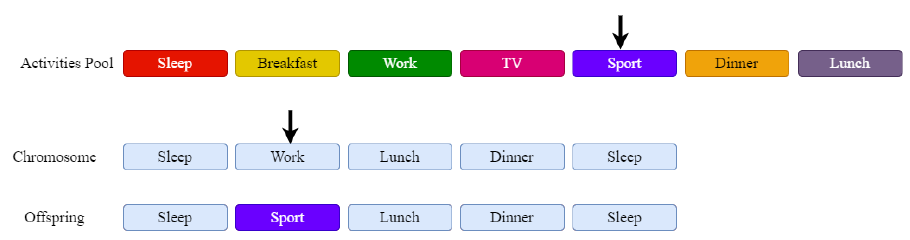
Figure 6. Example of applying mutation with random selection.